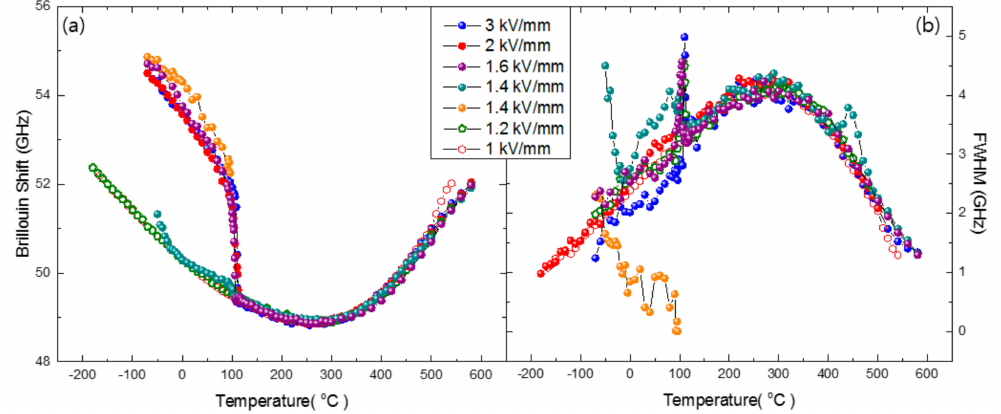
Figure 5. Temperature dependence of ( a ) ν B and ( b ) Γ B of the LA mode of NBT- x BT with x = 5% prepoled at room temperature under several electric fields. The phonon propagation direction is along the <100>